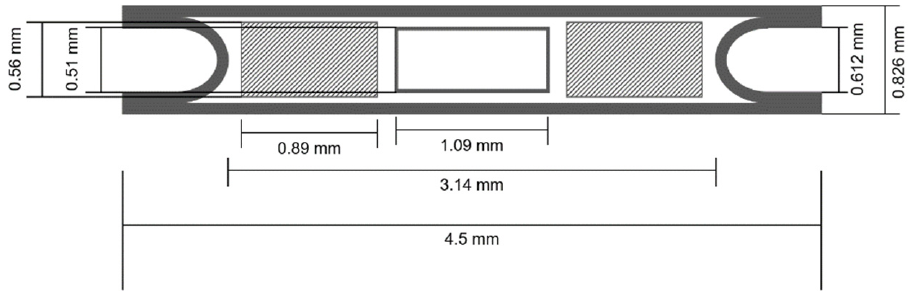
Figure 4. Schematic drawing of the commercial brachytherapy seed indicating the dimension of the different components in millimeters. The diagonally shaded rectangles on the sides represent the 103 Pd, the white rectangle in the center depicts the lead marker, all encased in a titanium cylinder closed by two arced end cups.